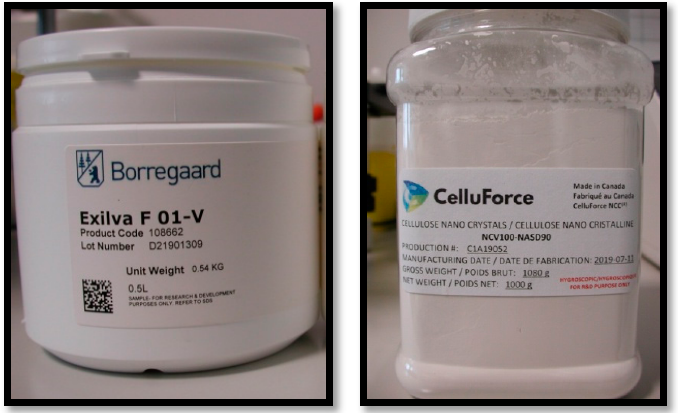
Figure 2. Cellulose used for this study: microfibrillar F cellulose (MFC) EXILVA and CelluForce ® nanocrystalline cellulose (CNC).